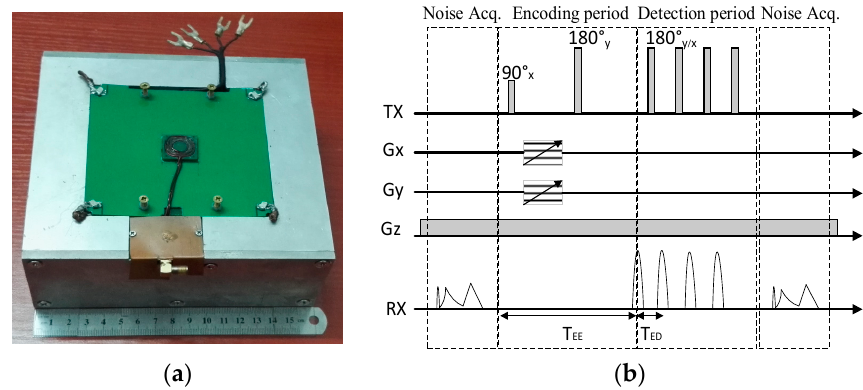
Figure 5. ( a ) New UMRI sensor created with a 2D gradient coil system. The probe measures 166 mm × 164 mm × 69 mm and weighs slightly over 8 kg; ( b ) CPMG-CP sequence utilized for the 2D image. For 1D image, G y was set to zero when the object structures in the x -direction was imaged, and G x was set to zero when the object structures in the y -direction was imaged. For the 2D image, both G y and G x were set with the gradient amplitude from negative to positive values.